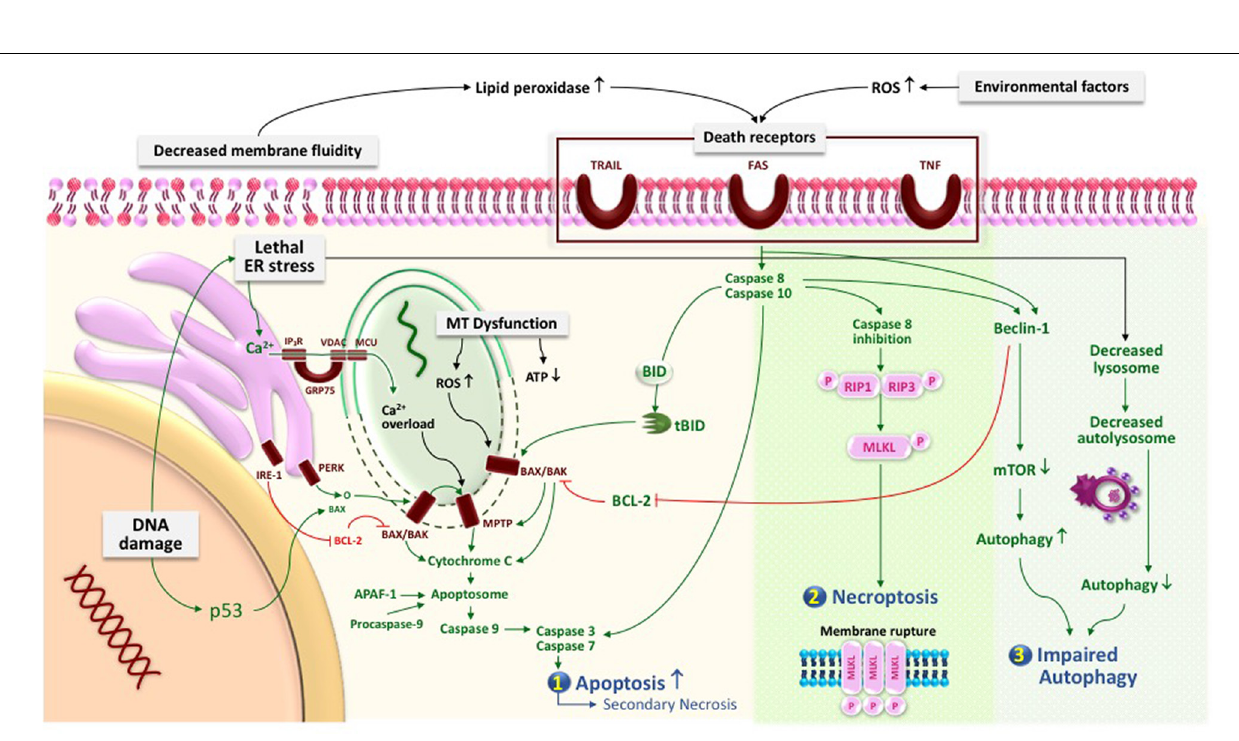
Frontiers in Cell and Developmental Biology |